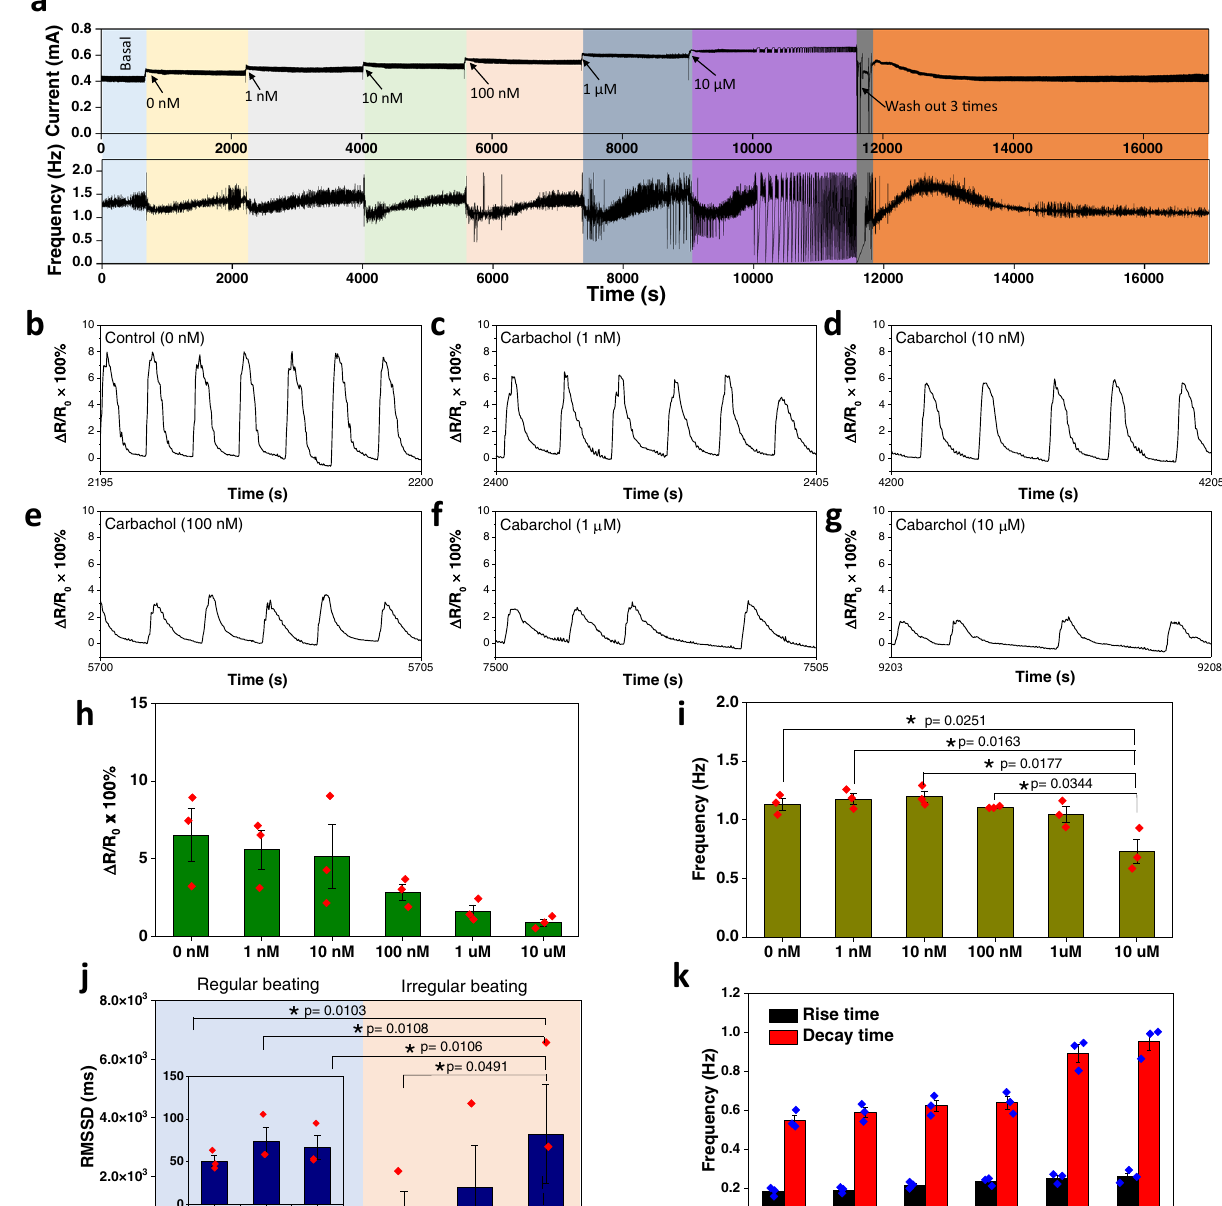
Fig. 4 | Instantaneous measurement of cardiac organoids treated with a chronotropicagent.a Continuousreal-timereadoutofthebeatingeventsandthe corresponding beating frequency changes from a cardiac organoid treated with cumulative doses of carbachol from 1nM to 10 μ M. b – g Enlarged views of the changingbeatingpatterns3minafter0nM( b ),10nM( c ),100nM( d ),1 μ M( e ),and